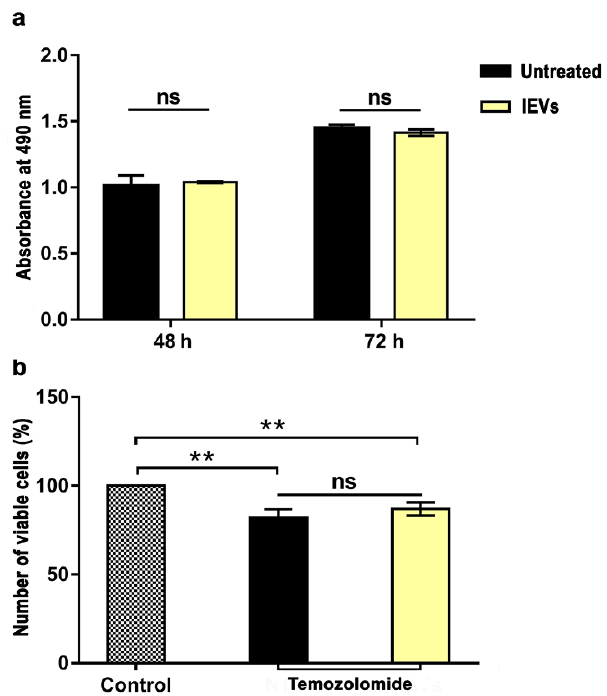
Figure 5. Cell proliferation and drug-sensitivity assay. ( a ) Cell proliferation assay. Absorbance of colorimetric assay of U87 cells after 48 and 72 h in absence (untreated) or presence of NTERA2 large extracellular vesicles (lEVs). No significant (ns) difference between the two samples was detected. ( b ) Temozolomide (TMZ) drug-sensitivity assay after 72 h of treatment, in combination or not with NTERA2 lEVs. Cell viability decreased with TMZ treatment, but no significant differences were detected between the effect caused by TMZ alone or in combination with NTERA2 lEVs. The results are shown as means ± standard error of mean from two independent experiments, each one in duplicate. ns not significant, ** p <